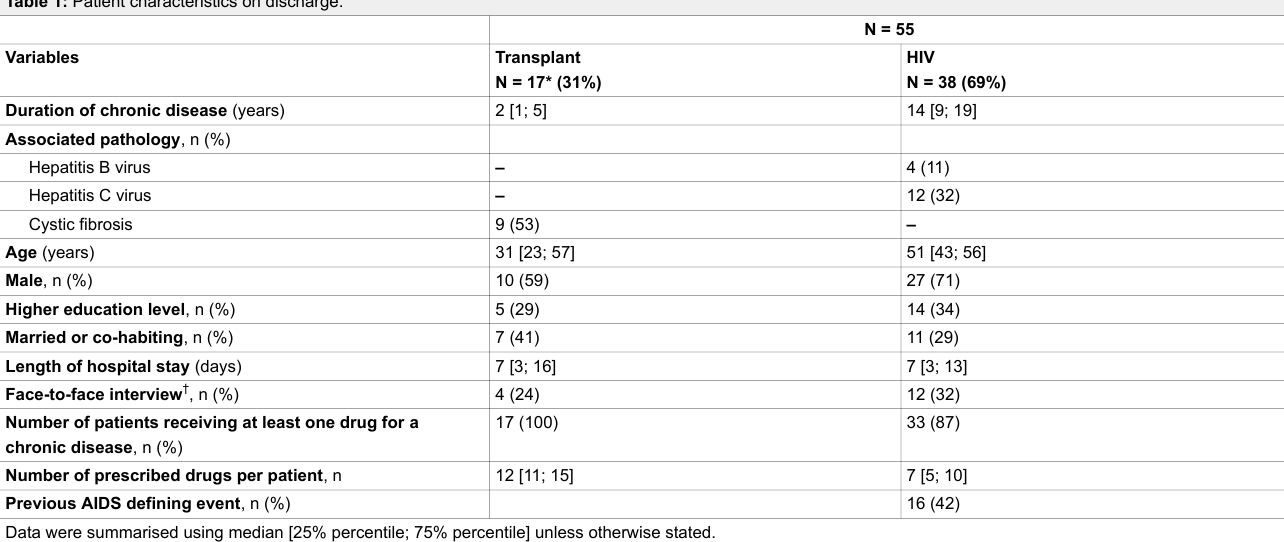
Table 1: Patient characteristics on discharge.